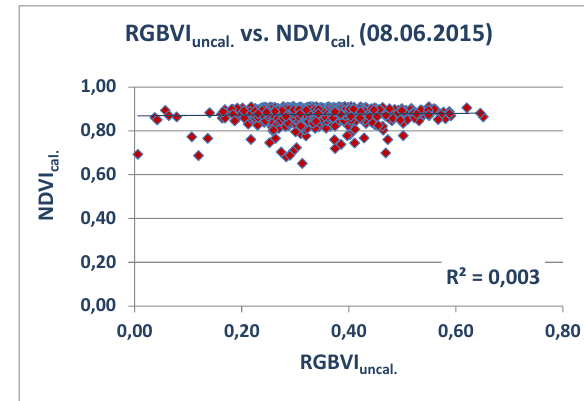
Figure 11. Evaluation of the RGBVI uncal. vs. NDVI cal. Figure 12. Evaluation of the RGBVI uncal. vs. NDVI